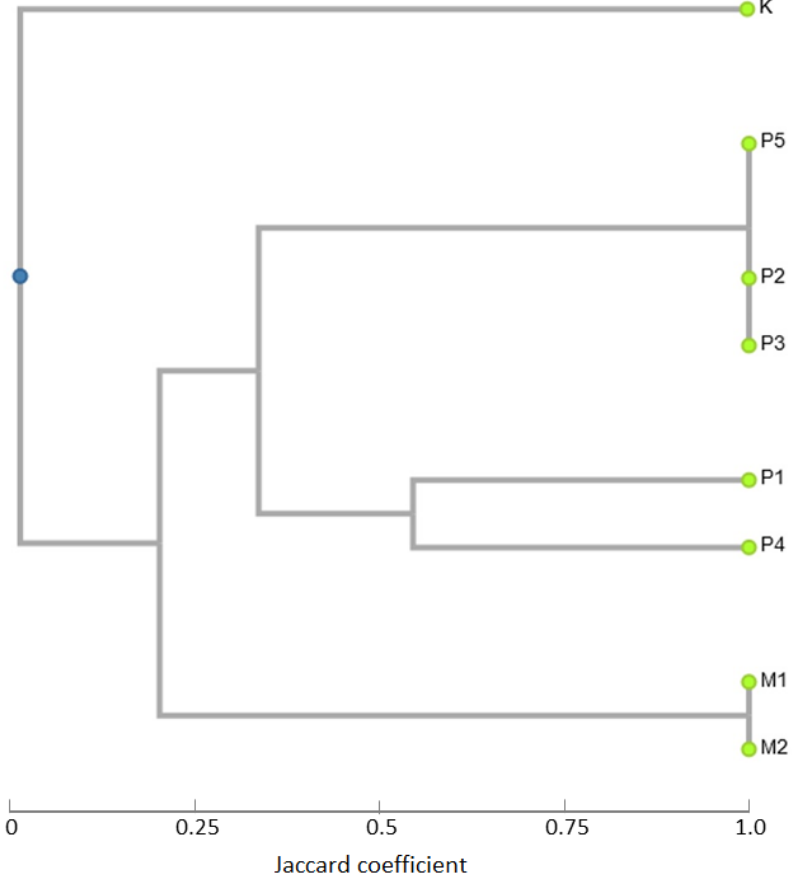
Figure 6. Dendrogram of analyzed C. fragrans genotypes based on CDDP results.